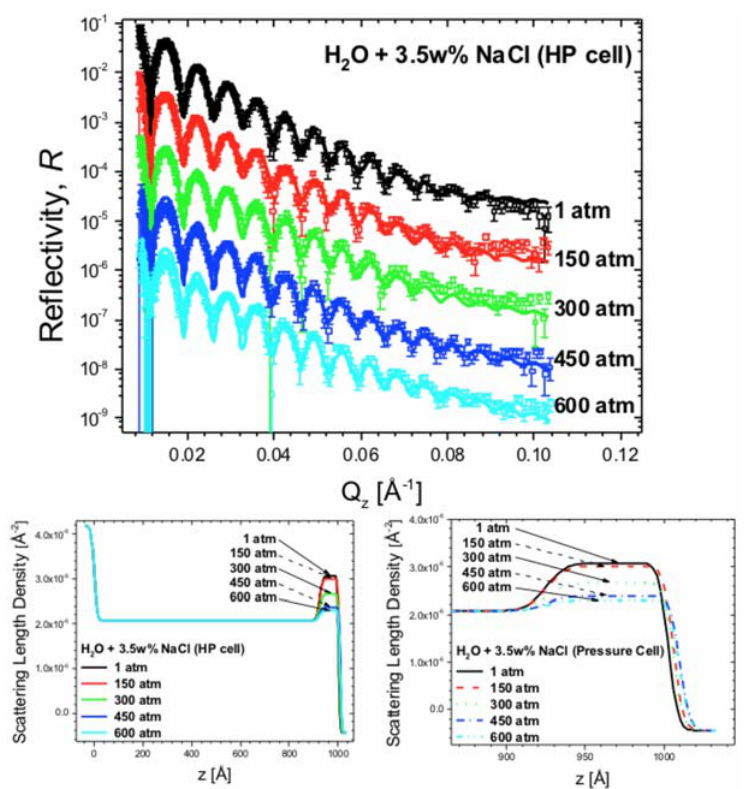
Figure 9. ( Top panel) Five NR measurements of Al film deposited on quartz substrate and investigated at 25 °C in contact with H 2 O + 3.5 wt. % of NaCl at different pressures. Solid curves are fits corresponding to the SLD profiles shown in the middle and right panels. Both the NR data and fits are offset by a decade along y ‐ axis for clarity; ( Bottom left panel) SLD distribution of the Al/Al 2 O 3 /liquid system and ( Bottom right panel) magnified SLD distribution in the contact region. In both of the bottom panels, z = 0 at the quartz substrate/Al interface.